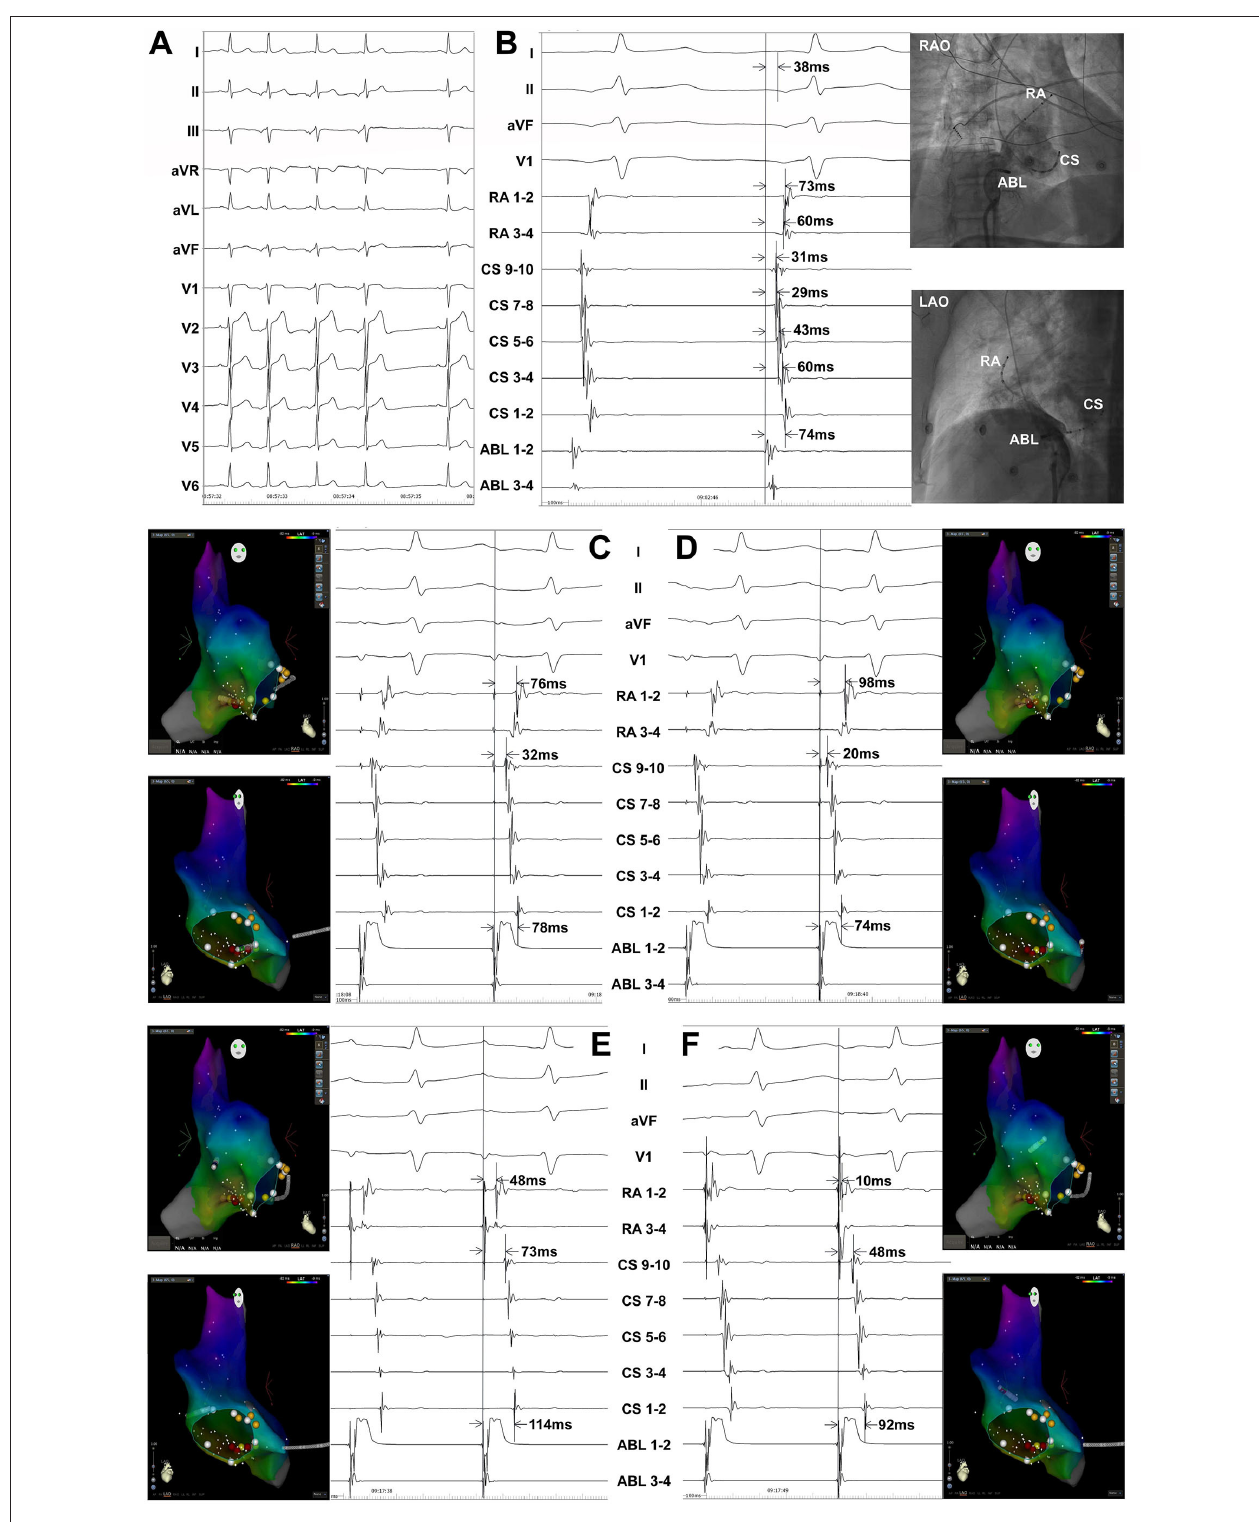
FIGURE 2 | Atrial pacing at different sites in a patient with PACs originating from inferior vena cava showing the atrial activation sequences and activation times of the right atrium (RA) and coronary sinus (CS). Surface ECG leads I, II, aVF, V 1 , RA 1 − 2 ∼ RA 3 − 4 , CS 9 − 10 ∼ CS 1 − 2 , and ABL 1 − 2 ∼ ABL 3 − 4 were simultaneously recorded. The RA catheter was advanced in the right atrial appendage. (A) Twelve-lead surface ECG monitoring at baseline. A negative P wave was seen in the inferior leads and the